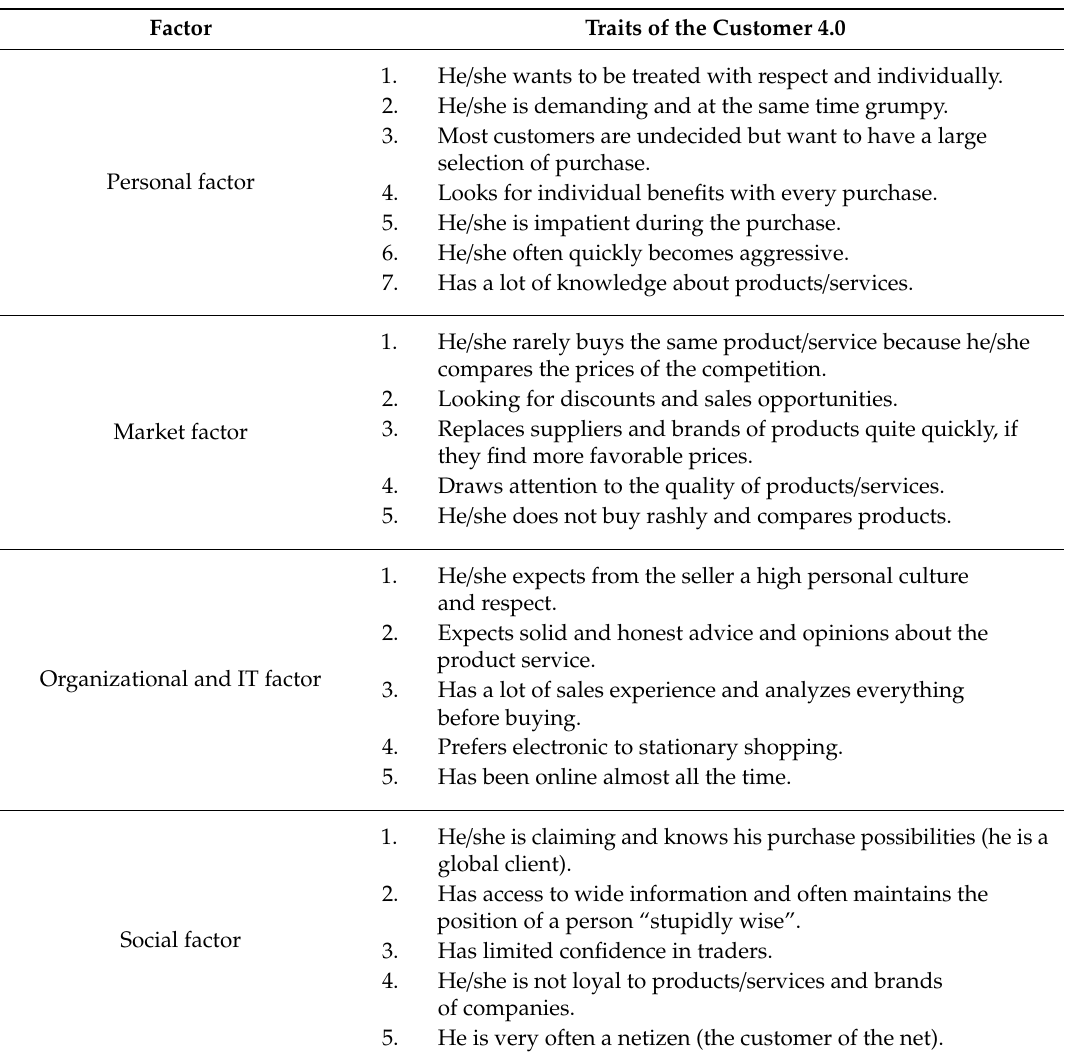
Table 4. Characteristics of Customer